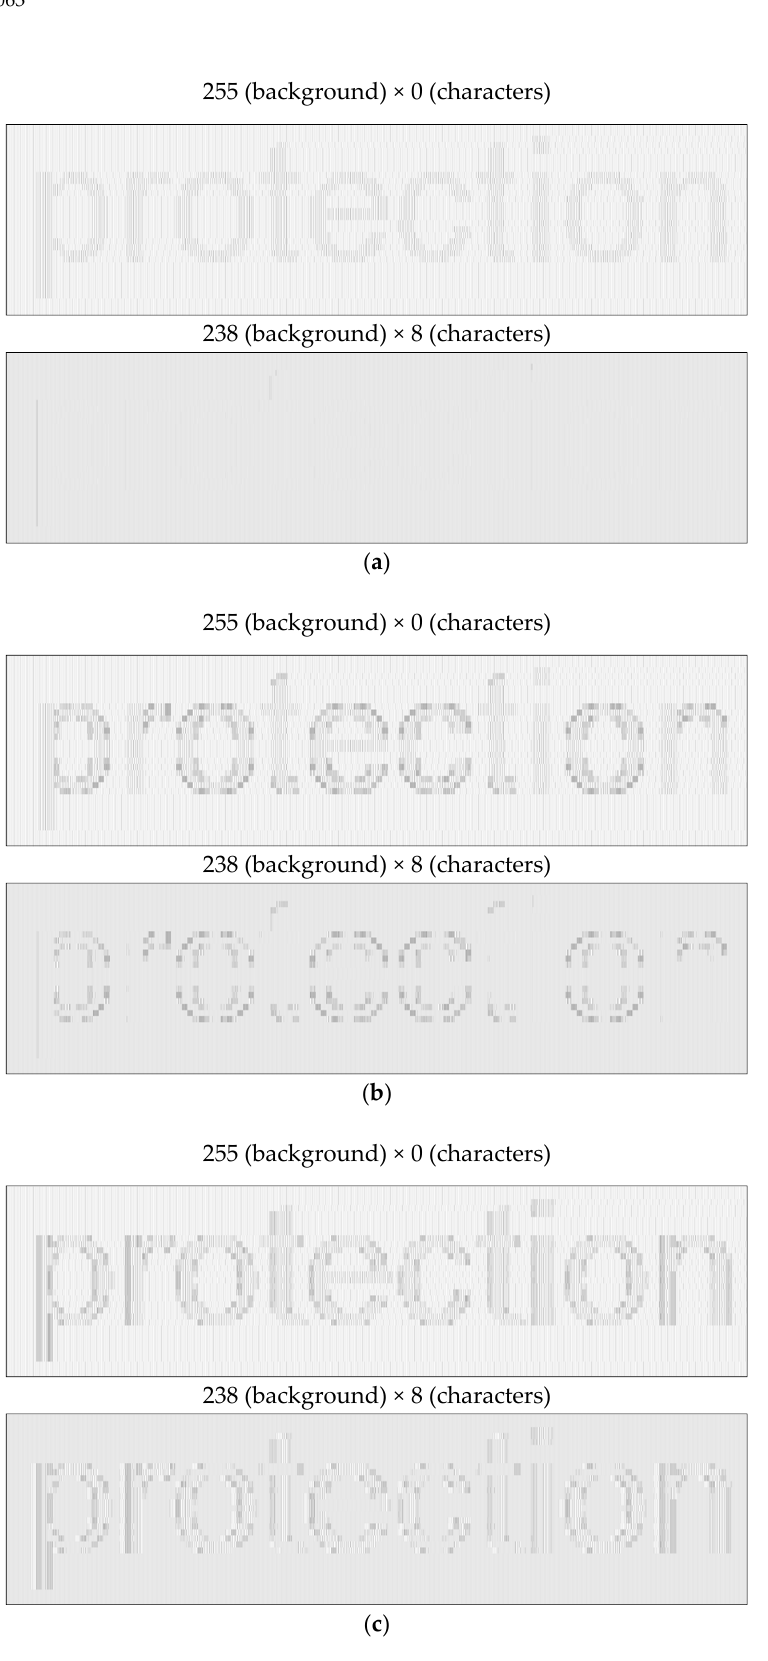
Figure 12. Examples of images obtained based on compromising emanations for di ff erent color pairs (background and characters) and for three edge smoothing modes (using Windows XP OS) for theoretical analysis: ( a ) without an edge smoothing mode, ( b ) Standard edge smoothing mode, and ( c ) ClearType edge smoothing